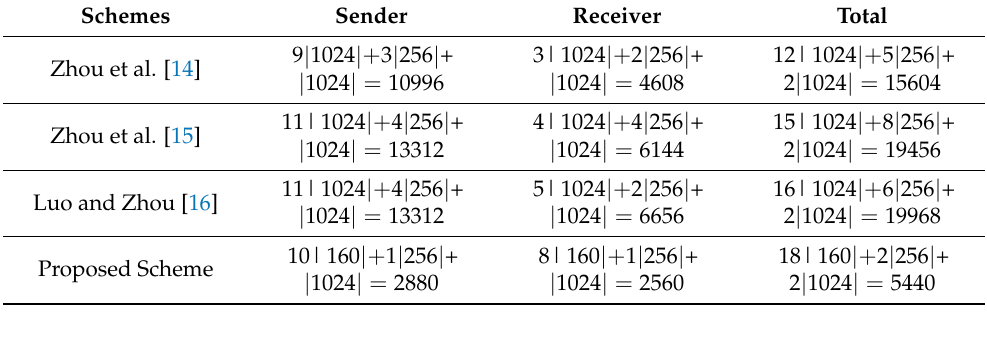
Table 6. Memory Overhead Analysis in Bits.